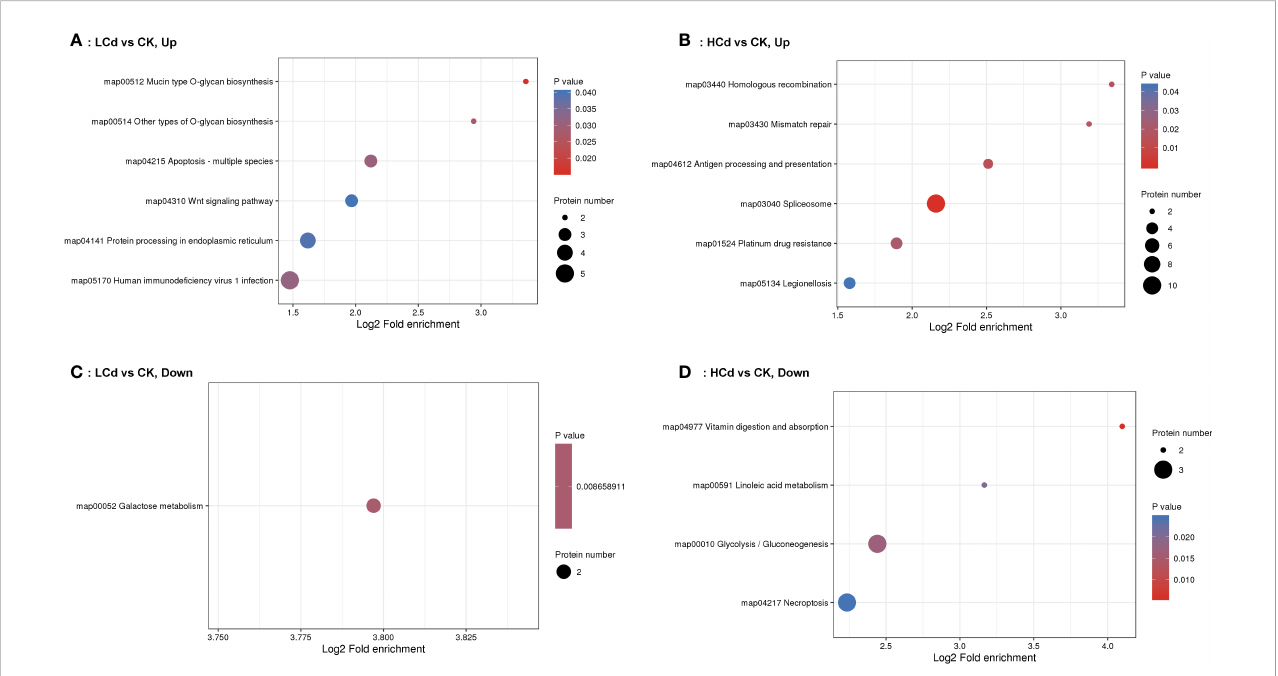
FIGURE 4 KEGG pathway enrichment analyses of up and low-regulated differentially expressed proteins (DEPs) detected in gill mussels of Gigantidas platifrons treated with LCd (100 µg/L Cd) or HCd (1000 µg/L Cd). (A) up-regulated DEPs, LCd; (B) up-regulated DEPs, HCd; (C) down-regulated DEPs, LCd; (D) down-regulated DEPs,